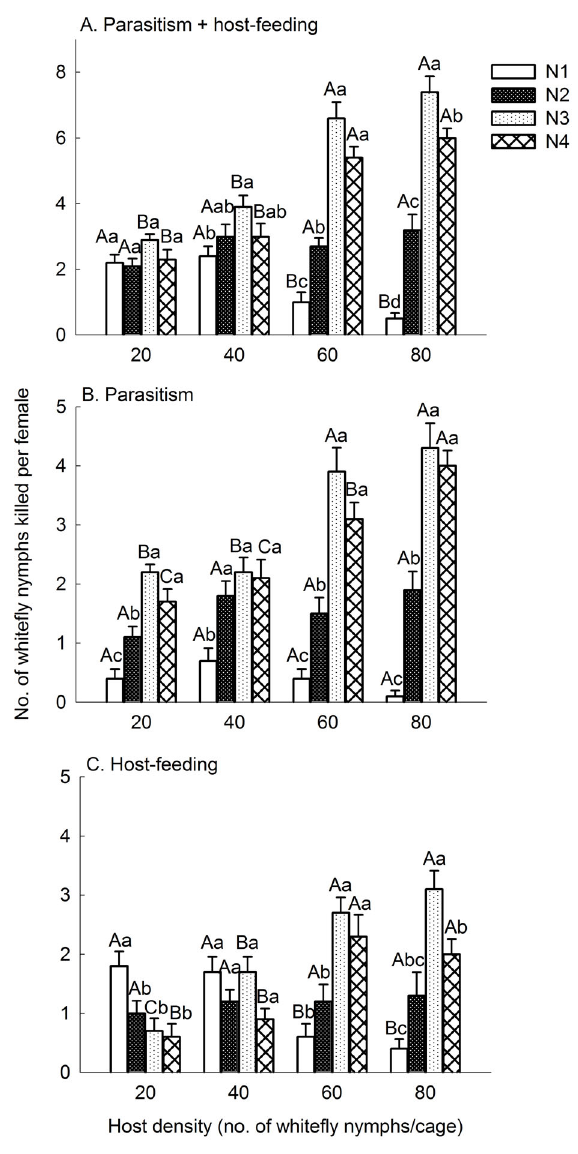
Figure 3. Mean number of whitefly nymphs killed Encarsia sophia in mixed-instar hosts experiment. A: killed by parasitism and host-feeding in 24 h; B: killed by parasitism in 24 h; C: killed by host- feeding in 24 h. An area of 3.5 cm 2 of a leaf on a potted tomato plant was covered by a clip cage. Host instars, N1, N2, N3 and N4 are first, second, third and early fourth instars, respectively. Bar heads with different lowercase letters in each cluster indicate significant differences (HSD test; P , 0.05) in number of hosts parasitized or fed among different host instars. Bar heads with different capital letters for each instars between the clusters indicate significant differences (HSD test; P , 0.05) in number of hosts killed among different host densities. Vertical bars indicate 6 one